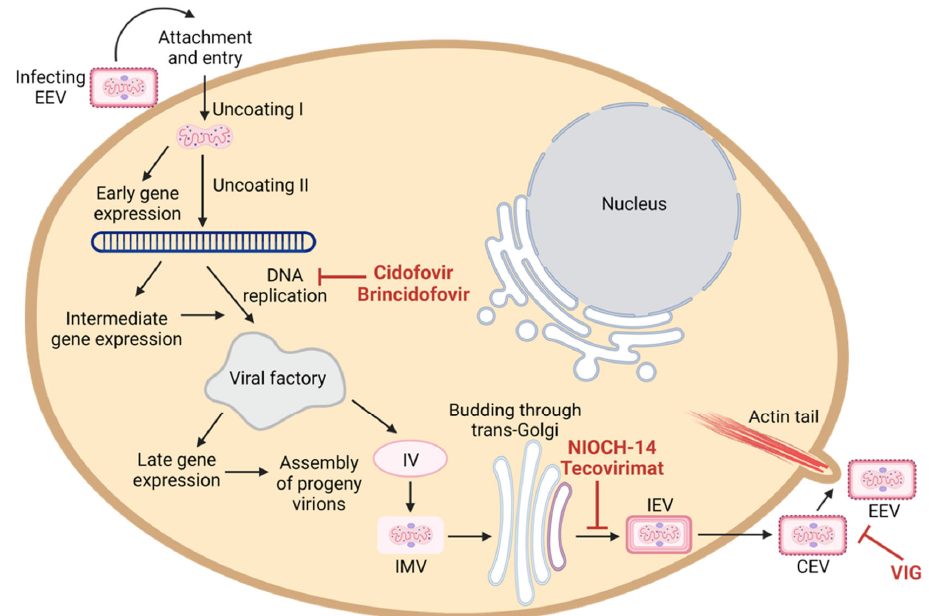
Figure 6. Schematic overview of the monkeypox virus life cycle and the mechanism of action of anti-poxvirus drugs. Like all poxviruses, monkeypox replicates in the cytoplasm of infected cells. Cidofovir and brincidofovir inhibit viral DNA polymerase; tecovirimat and NIOCH-14 prevents the formation of the cell-associated enveloped virion (CEV) and extracellular enveloped virion (EEV); and VIG prevents virion to infect new cells. The figure was created by The antiviral potency of tecovirimat against monkeypox virus was evaluated in vitro and in various animal models. A submicromolar concentration of tecovirimat was shown to inhibit plaque formation of broad ‐ spectrum orthopoxviruses, including monkeypox vi ‐ rus in cell culture assays [80–82]. The efficacy of oral administration of tecovirimat against monkeypox virus was shown in multiple animal models, including ground squirrels, prai ‐ rie dogs, and nonhuman primates [78,83–85]. Non ‐ human primates infected with a lethal dose of monkeypox indicated that a dose of 10 mg/kg initiated on day 4 or 5 post ‐ infection for at least 7 consecutive days was sufficient to provide maximum survival rate and de ‐ crease in viral load [78]. Because smallpox was eradicated, the development and approval of tecovirimat were conducted under the under FDA Animal Rule 21 CFR 314 Subpart I [86]. Thus, the effective doses of tecovirimat in nonhuman primates that protect the ani ‐ mals from a lethal dose of orthopoxvirus infections were extrapolated and used for clinical trials [87]. A phase III clinical trial (NCT02474589) further validated the safety and phar ‐ macokinetics of an oral regimen 600 mg twice daily for 14 days to a large group of human volunteers [78].